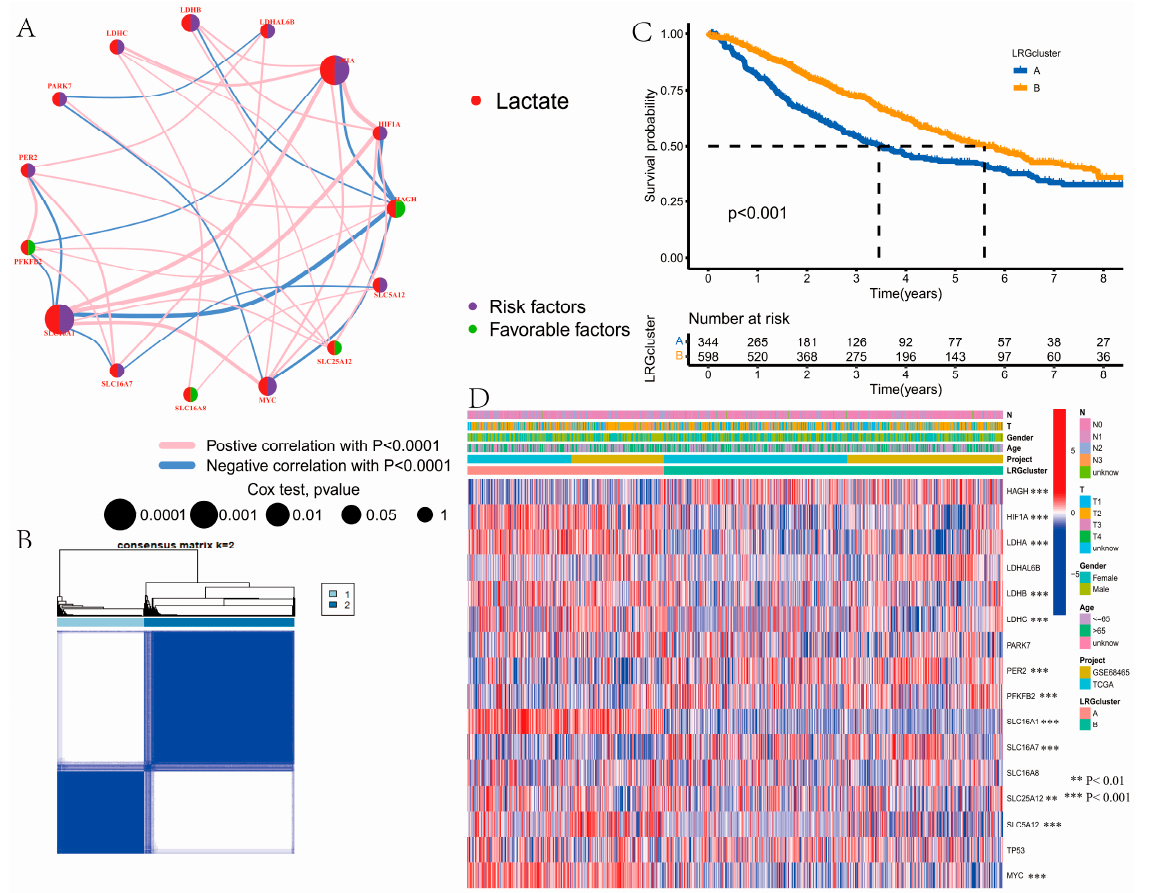
Figure 2. Identification of lactate clusters in lung adenocarcinoma (LUAD). ( A ) The lactate-related gene (LRG) interactions and their prognostic value in LUAD. ( B ) The result of consensus clustering analysis based on LRGs. The samples with LUAD were classified into LRG cluster A ( n = 344) and B ( n = 598), which were the best choices when k = 2. ( C ) Differences in overall survival (OS) between the two distinct subtypes. The patients in LRG cluster B had a better prognosis than patients in LRG cluster A (log-rank test, p < 0.001). ( D ) The expression levels of LRGs and clinicopathological features of samples with LUAD between the two LRG clusters. ** P < 0.01, *** P < 0.001.